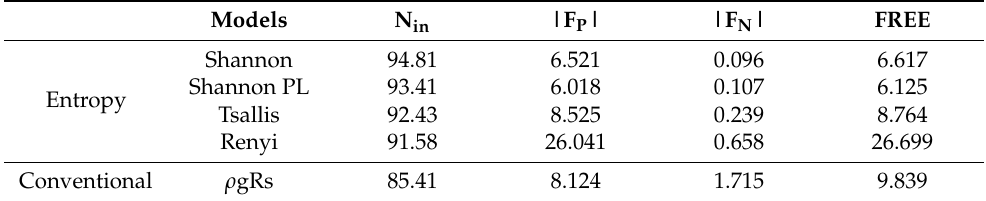
Table 2. Statistical indexes based on HBMES-1 uncertainty method in shear stress prediction by different entropy models and the conventional ρ gRs